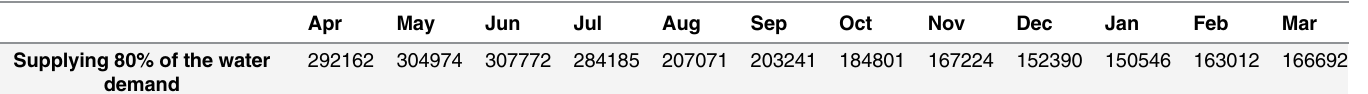
Table 5. The average results of hydroelectric power generation of Karun 1 using ε – constraint algorithm